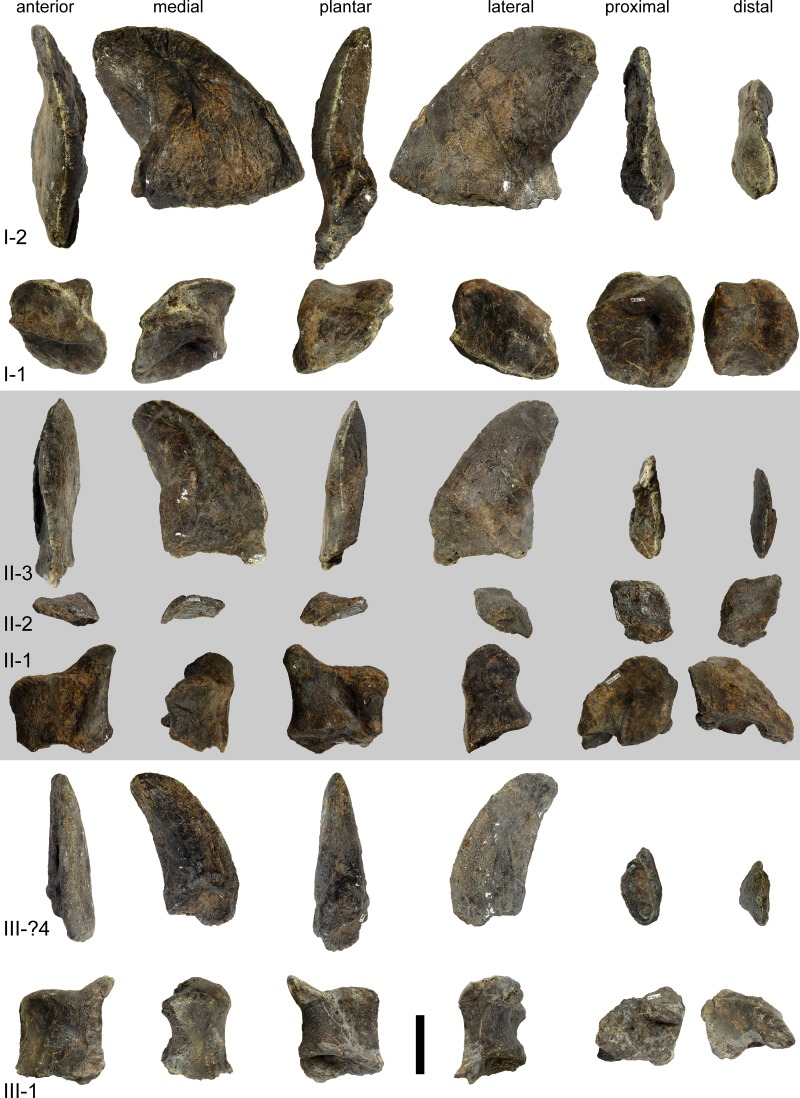
Left pedal phalanges of Galeamopus pabsti SMA 0011.The phalanges are shown in anterior, medial, plantar, lateral (distal surface towards the top), proximal, and distal view (plantar surface towards the bottom). Digits are indicated on the left with roman numbers. Scale bar = 5 cm.